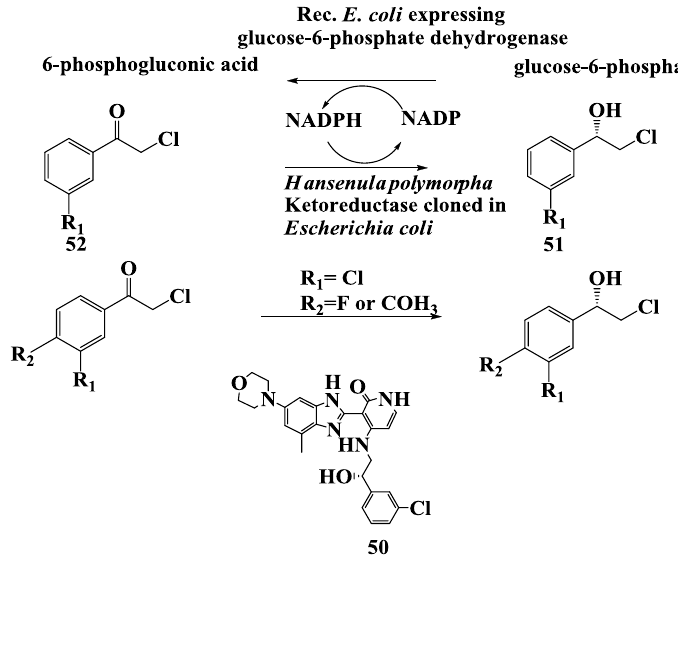
Figure 13. Anticancer drug: Enzymatic preparation of ( S